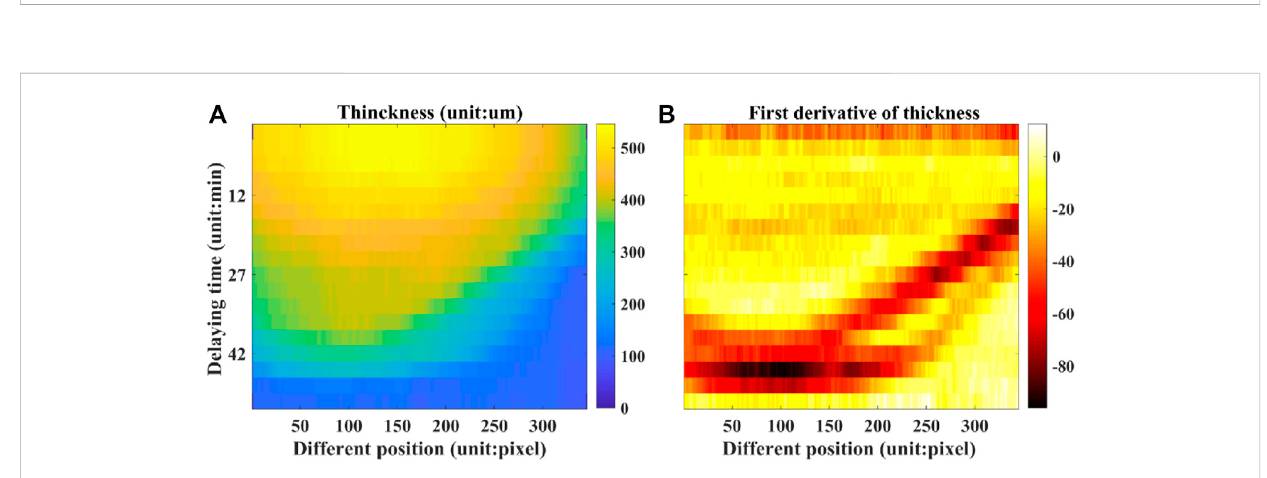
FIGURE 9 (A) Pixel-wise thickness map and (B) corresponding fi rst derivative of whole blood during coagulation and drying processes.